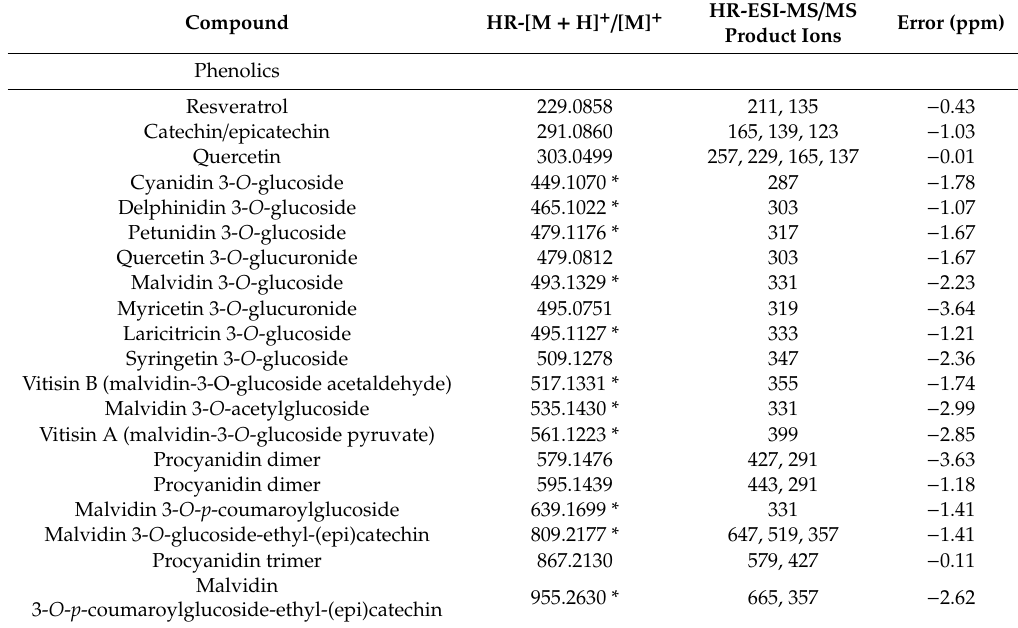
Table 5. Main components of the Aglianico grape pomace